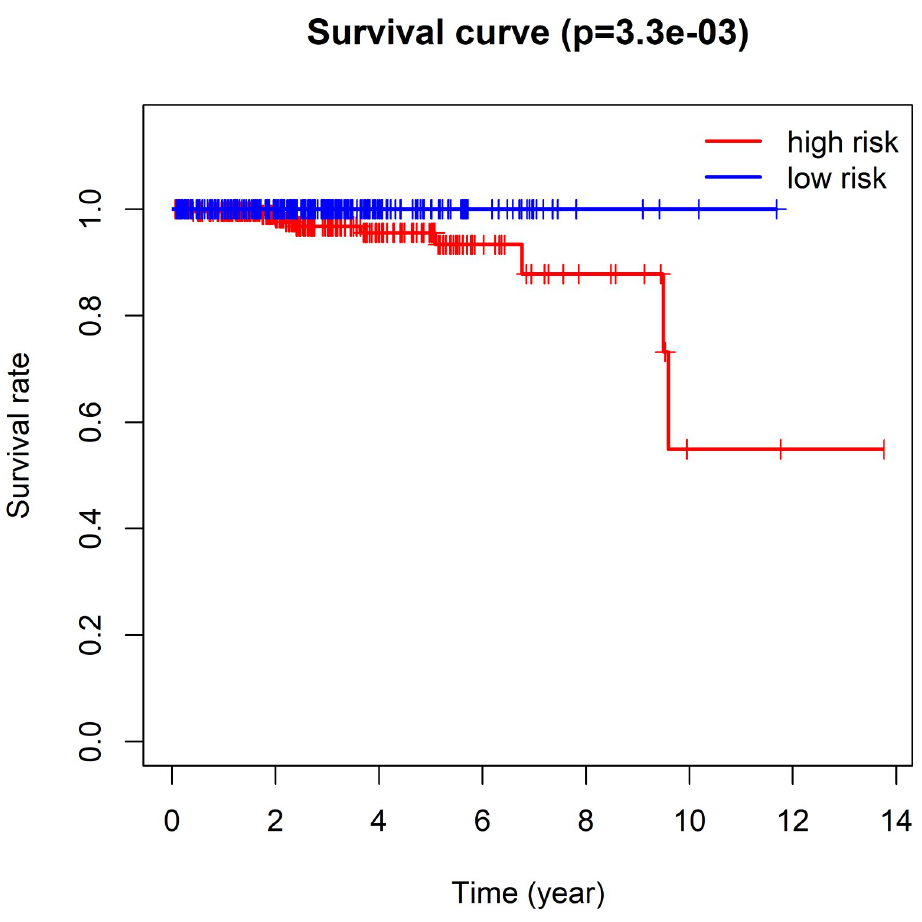
Fig 6. Prediction ability of the four-lncRNA nomogram evaluated by Kaplan-Meier analysis, log rank P and C- index based on TCGA data. OS time between low- and high-risk groups were visualized and compared by plotting the Kaplan-Meier